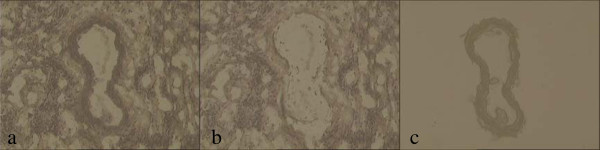
Harvest the cancer stromal vasculature by LCM. (a) Before LCM; (b) after LCM; (c) the microdissected stromal vasculature on cap.